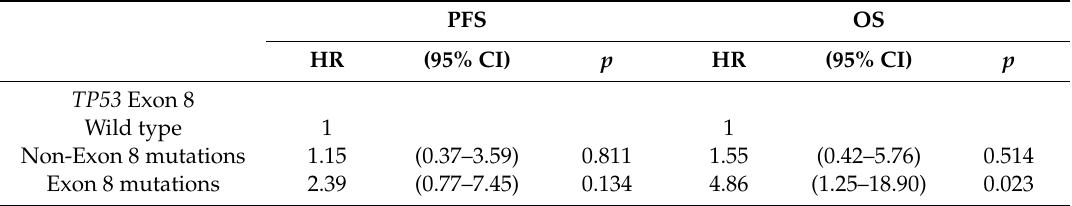
Table 4. TP53 mutations in relation to progression-free survival (PFS) and overall survival (OS) of patients receiving osimertinib in second or further lines of